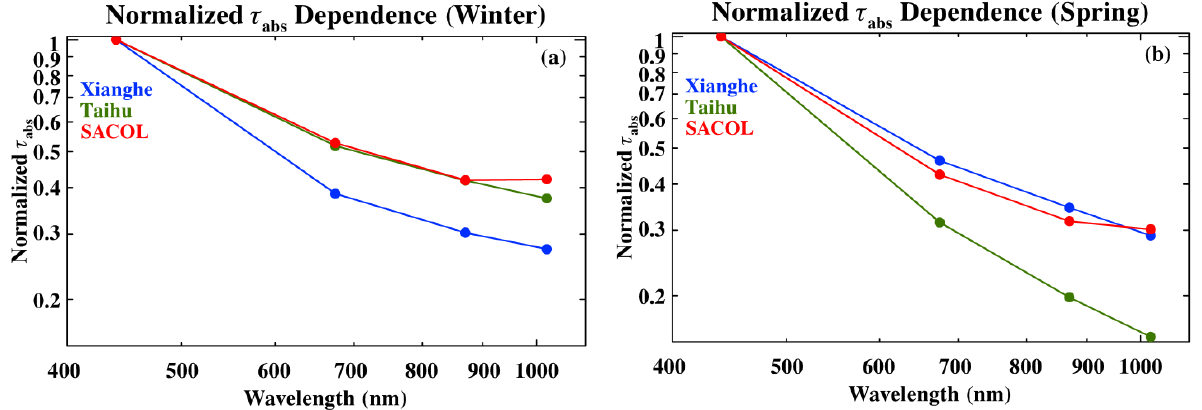
value in order to compare the 440